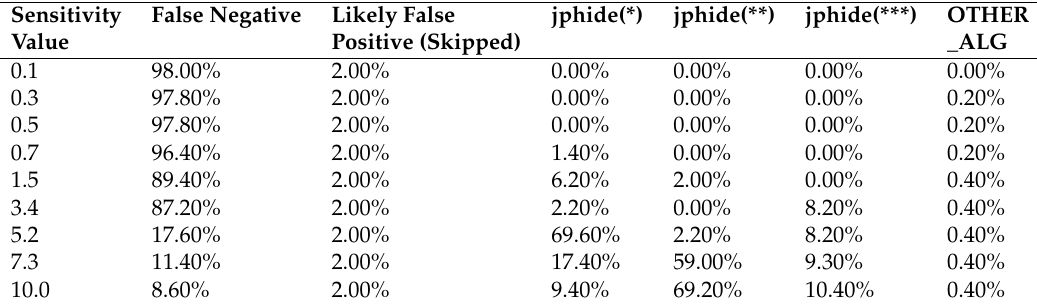
Table 2. Results from manipulated images by seam-carve based on sensitivity values.